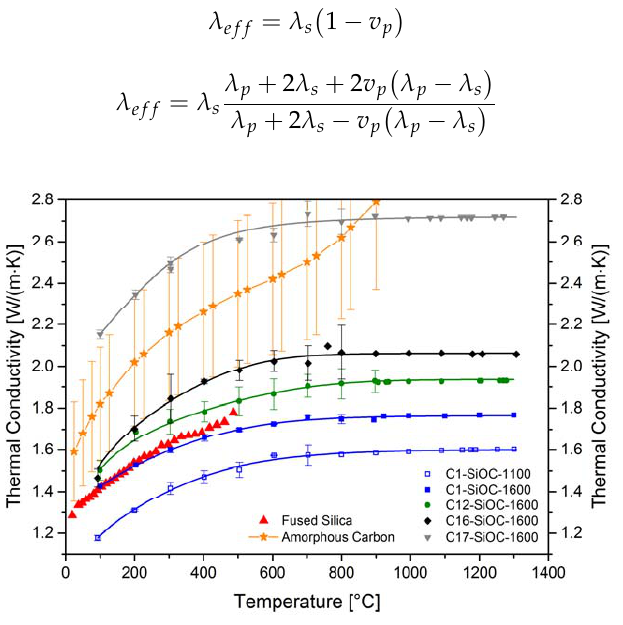
Figure 6. Thermal conductivity of SiOC glasses and glass ceramics. The data points represent the values measured; the solid lines are a guide for the eyes. The standard deviation is taken as the relative standard deviation according to the thermal diffusivity measurements. Data for fused silica and for amorphous carbon are taken from Cahill [52] and Ho et al. [53], respectively.